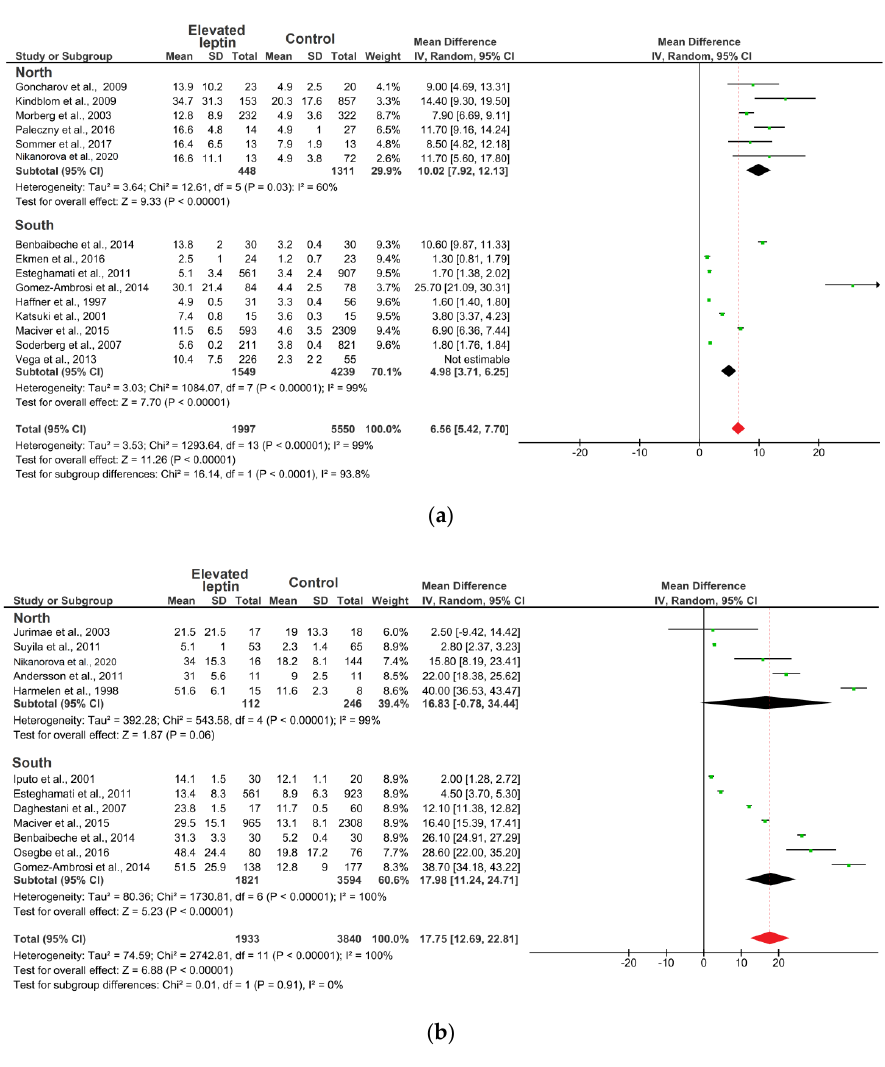
Figure 3. Forest plot of meta-analysis: Mean difference in the circulating level of leptin in subjects with elevated leptin and controls: ( a ) males; ( b ) females. Note: Mean—average value; SD—standard deviation; Dotted line—the point estimate of the averaged studies; Black diamond—the point estimation; Red diamond—the average point estimation.